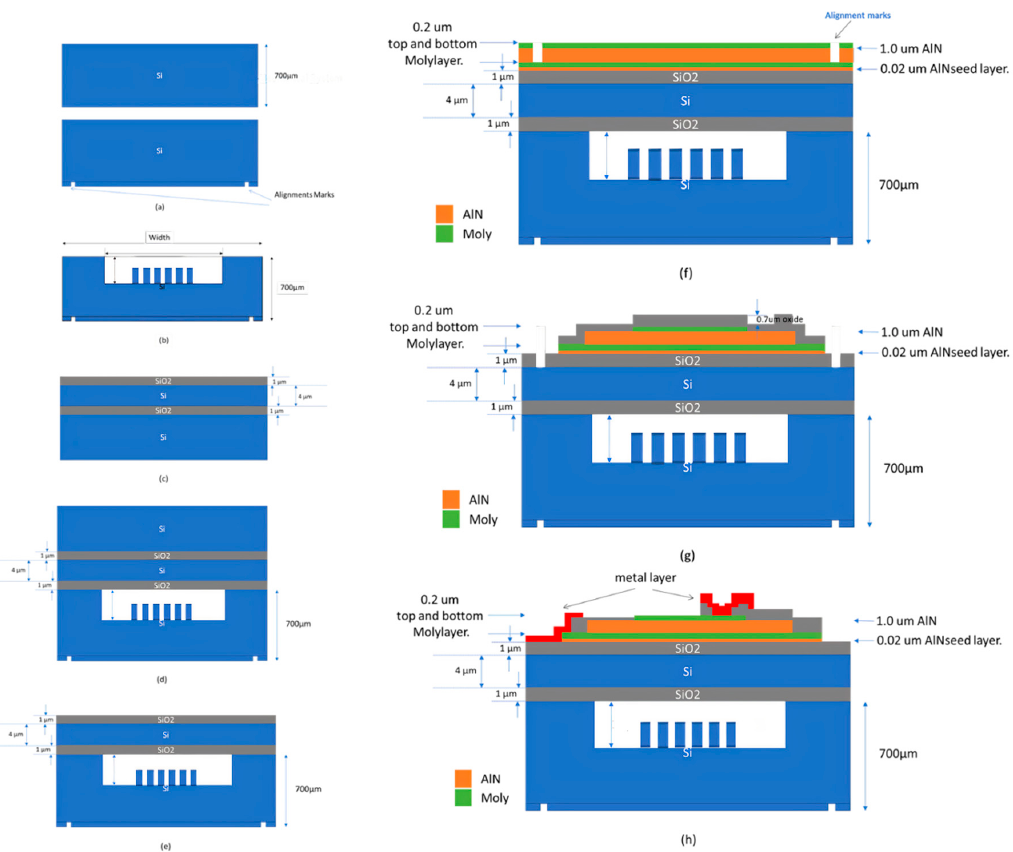
Figure 2. Sample fabrication process flow for piezoelectric AlN-based micro-machined infrasonic hydrophone sensor.